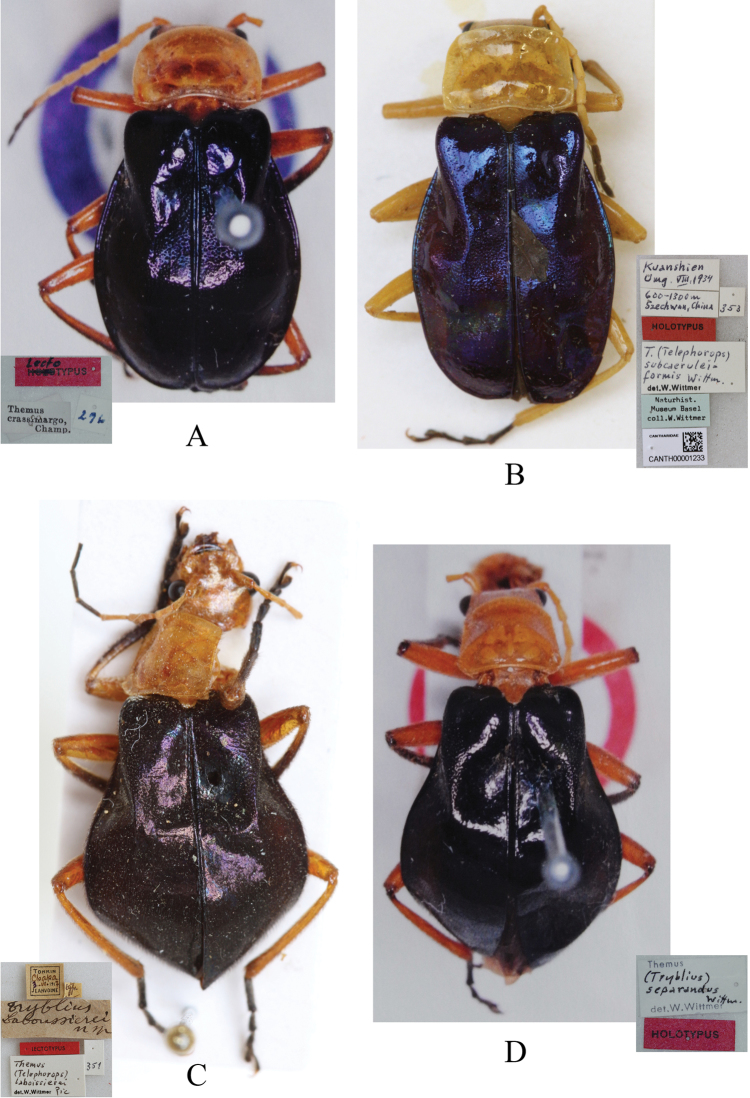
Habitus, dorsal view AThemus
crassimargo Champion, 1926 (lectotype) BThemus (Telephorops) subcaeruleiformis Wittmer, 1983 (holotype) CTriblius
laboissierei Pic, 1929 (lectotype) DThemus (Tryblius) separandus Wittmer, 1975 (holotype).